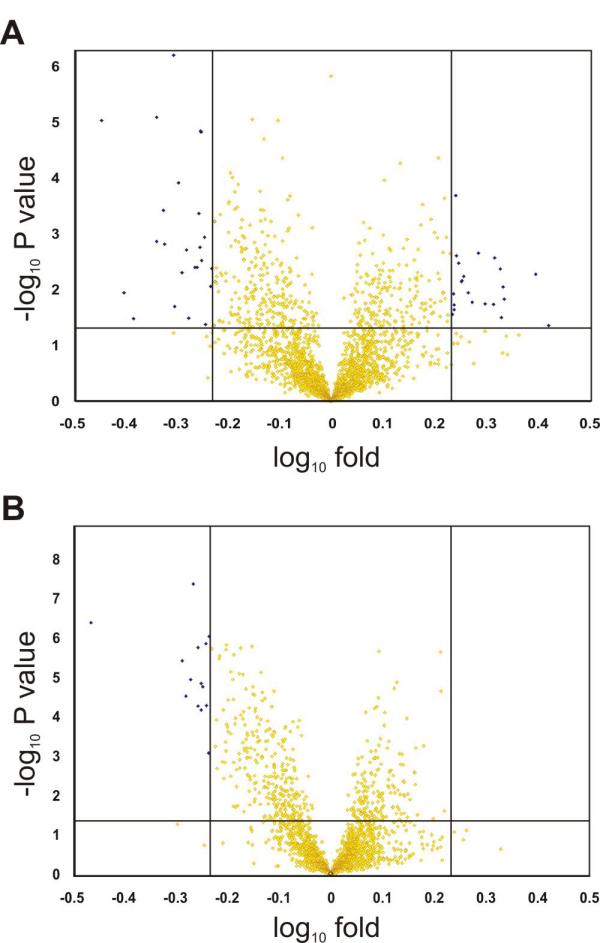
Both control correction and dye-swap methods reveal statistically significant changes in gene expression. Volcano plots of the control correction method (A) and the dye-swap method (B) reveal a small proportion of genes that met our arbitrary criteria of having >1.7 fold changes with p values <0.05, determined individually for each gene. The horizontal lines on each graph represent p = 0.05. The vertical lines represent 1.7 fold changes, both up- and down-regulated. Genes shown in blue in upper left and right areas were selected for northern blot confirmation.